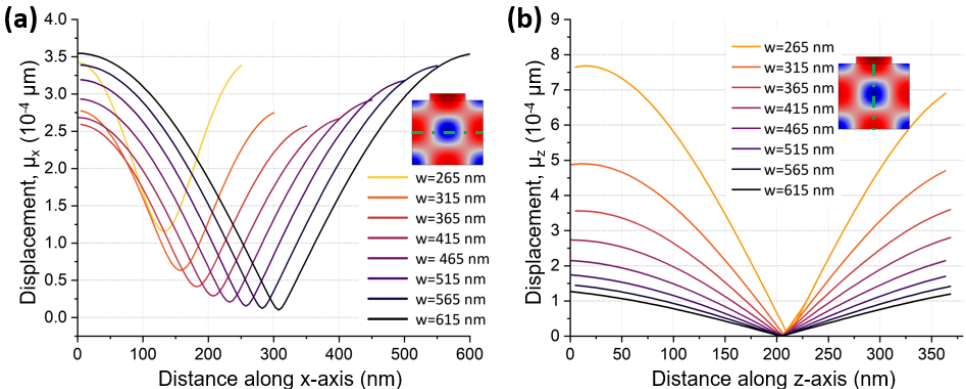
Figure 2. ( a ) Simulated displacement ( µ x ) along the dotted cut line on the x-axis. ( b ) Simulated displacement ( µ z ) along the dotted cut line on the z-axis. Data is simulated in Comsol®2D (ver. 5.6, Boston, MA, USA) for a fixed AlN and top metal thicknesses (383 nm and 40 nm,